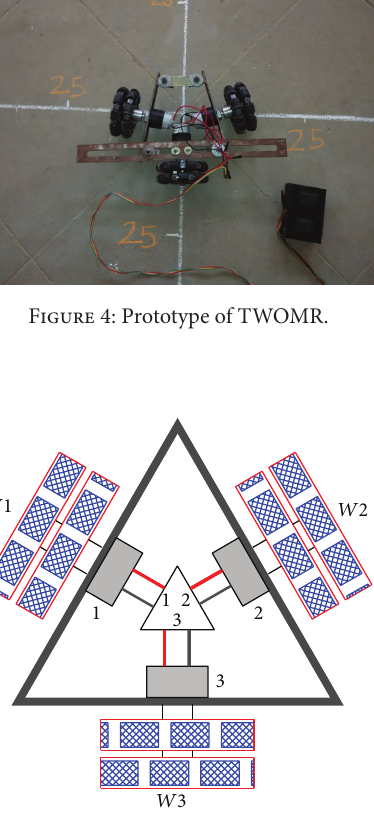
Figure5:ThecircuitdiagramofTWOMR(1,2,and3areDCmotors and 𝑊1 , 𝑊2 , and 𝑊3 are omniwheels).